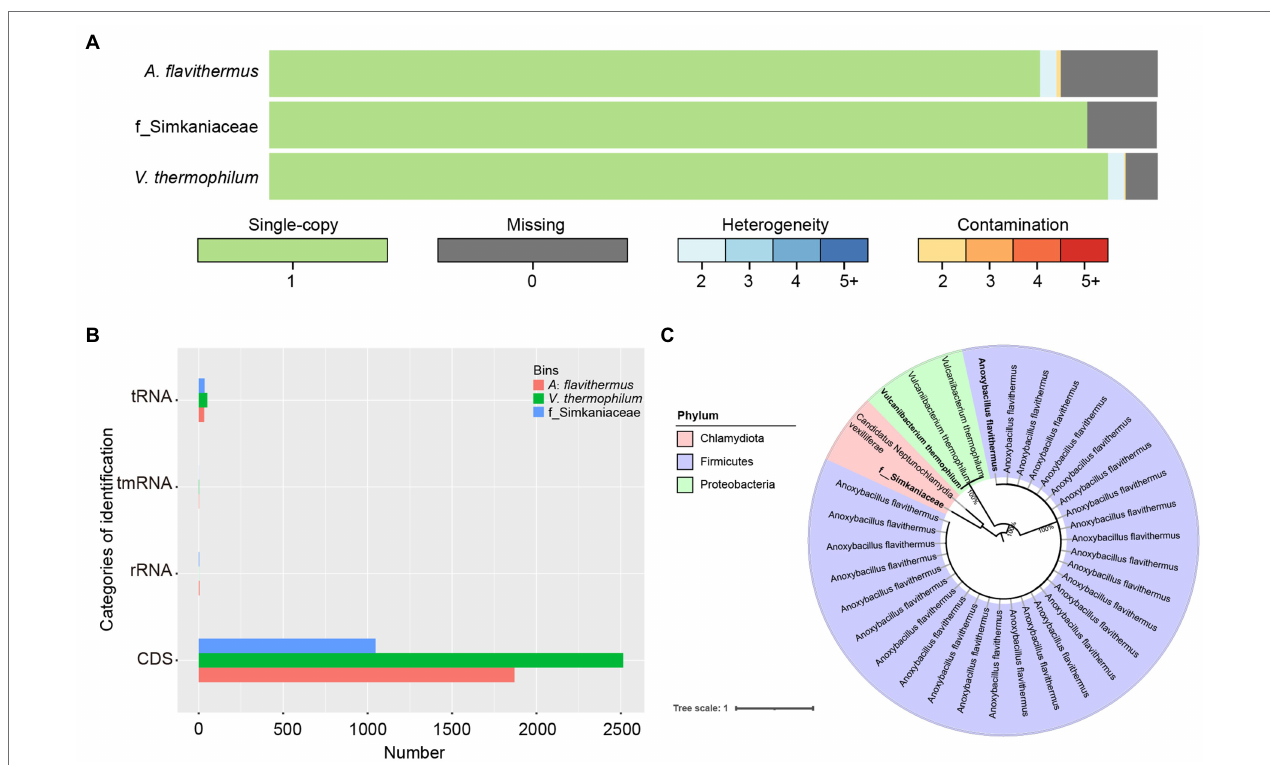
FIGURE 5 | Functional analysis of the individual bacterial bins. (A) Visualization of three bins obtained after quality control by CheckM and de-duplication by Drep, with single-copy genes in green, deletion genes in gray; blue gradient represents various heterozygosity rates; red represents contamination rates. (B) Comparison of the number of identifications among tRNA, tmRNA, rRNA and CDS. (C) Phylogenetic relationships of 29 Anoxybacillus flavithermus , three Vulcaniibacterium thermophilum , and two bacteria belonging to family Simkaniaceae were investigated using maximum-likelihood method. Three bacterial names in bolded were assembled in this study. Numbers at each node showed ML bootstrap